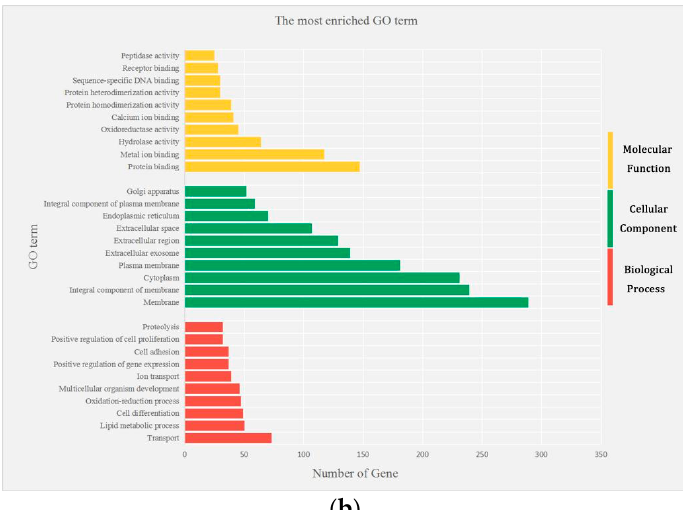
Figure 5. Gene Ontology (GO) distribution of differentially expressed genes of the testes and uterus transcriptome. The top 10 enriched GO terms under biological process, cellular component, and molecular function in ( a ) male mice infected with T. gondii and ( b ) female mice infected with T. gondii.